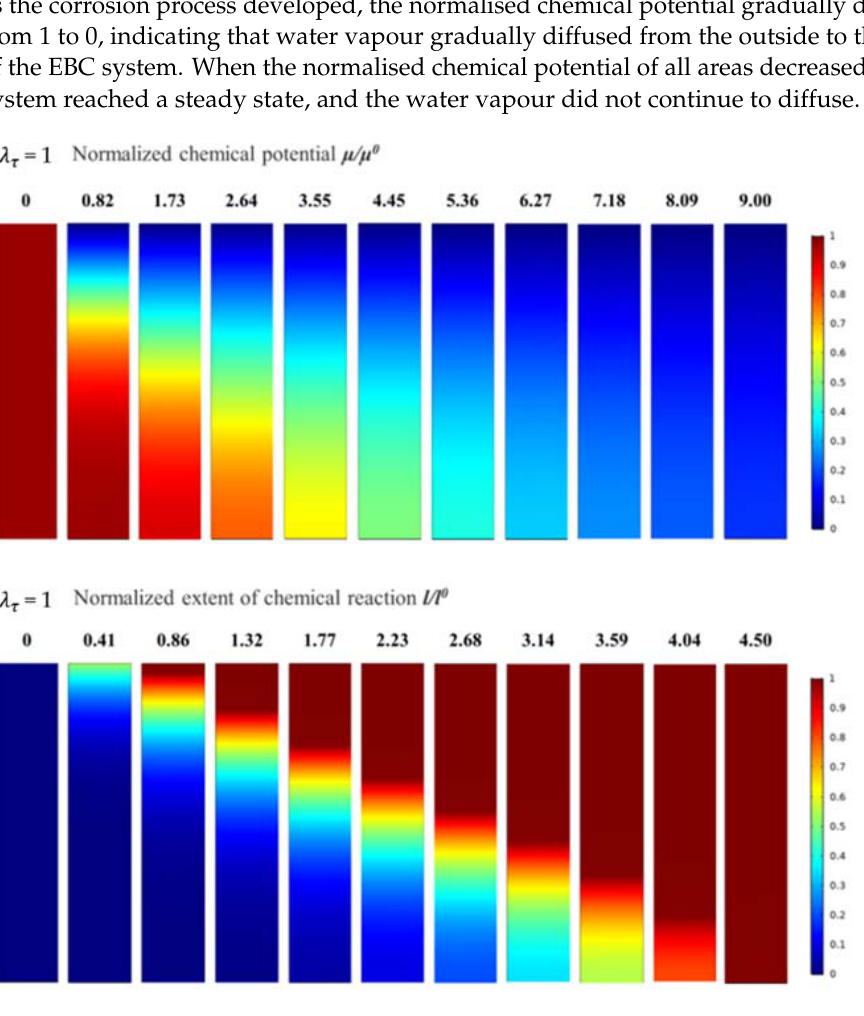
Figure 2. The evolution process of normalised chemical potential and normalised chemical reaction degree when λ (cid:2980) = 1.